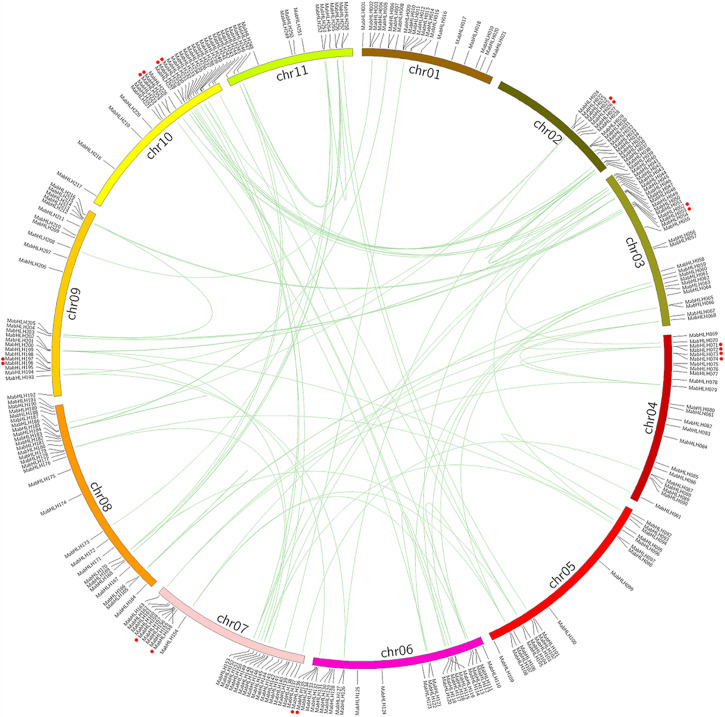
Distribution and synteny analysis of MabHLHs on the 11 chromosomes of M. acuminata genome. The locations of the MabHLH genes are indicated by vertical black lines. The segmental duplicate MabHLH genes are connected with green lines, and red dot indicates tandem duplicated MabHLH genes.